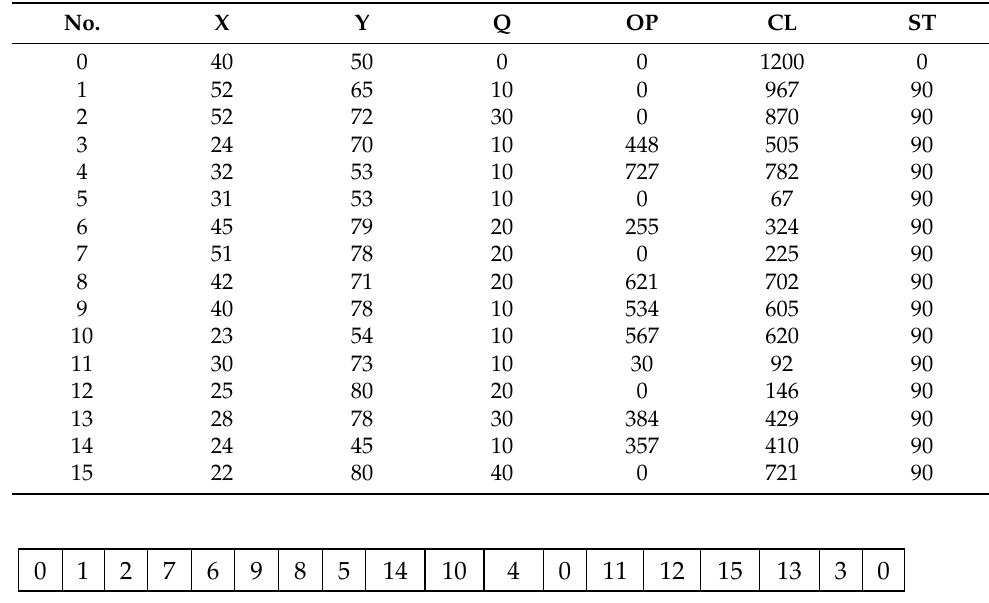
Figure 2. Example of solution representation .